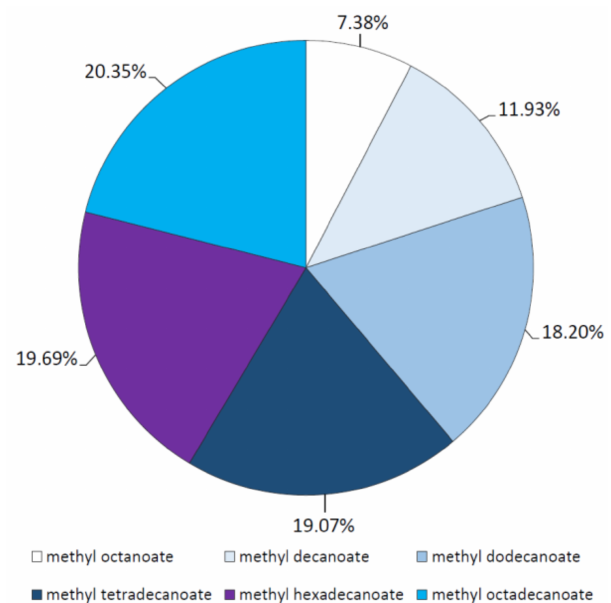
Figure 6. Percent distribution of methyl ester products formed during esterification reactions with the M. echinosphaera CBS 575.75 lipase. Reactions were performed at 40 ◦ C for 72 h in n -heptane containing 1 M methanol and various fatty acids, each in 10 mM concentration. The total methyl ester yield was taken as